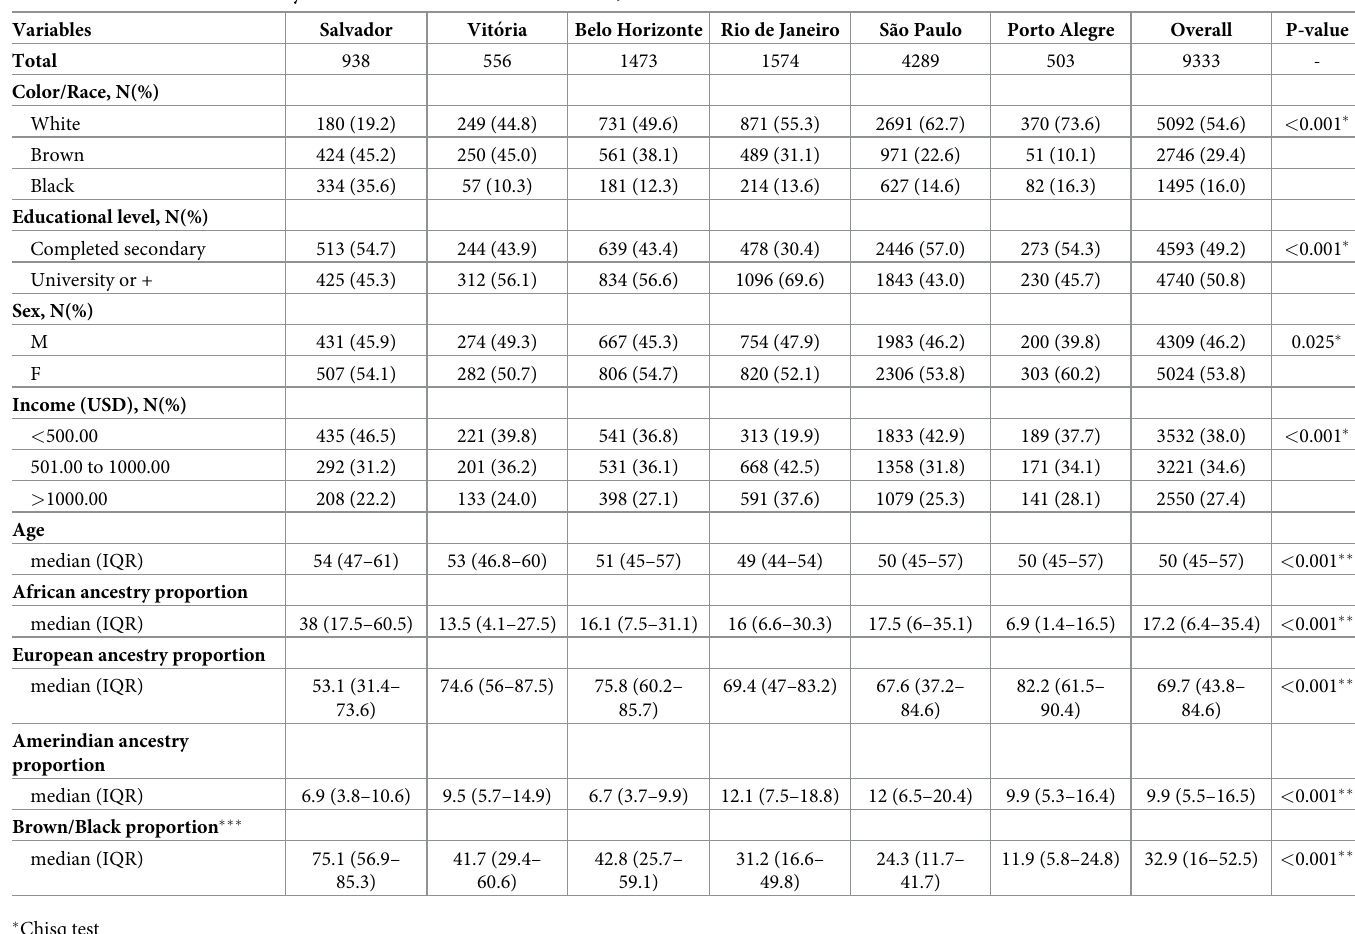
Table 1. Selected characteristics by research centre and total. ELSA-Brasil,